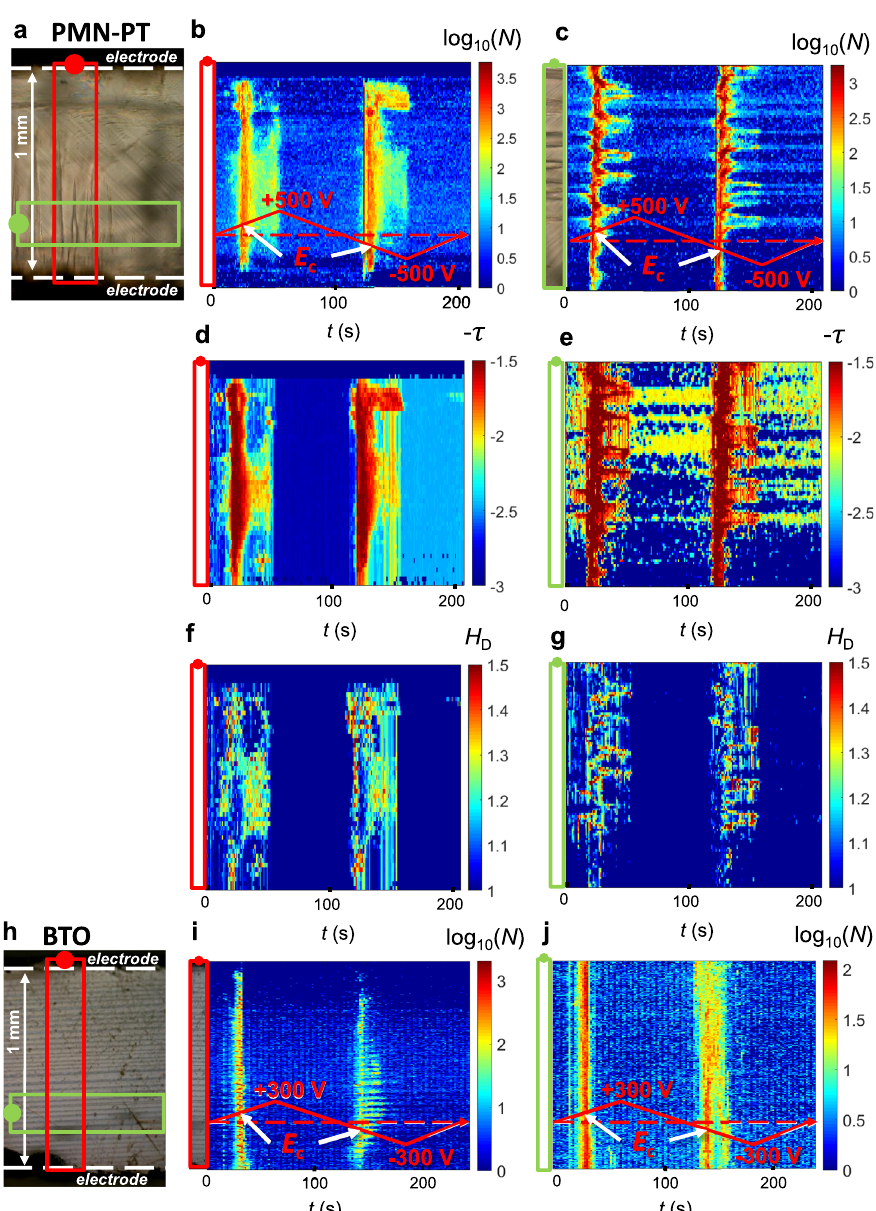
Fig. 2 Spatiotemporal avalanche maps. Spatiotemporal avalanche maps for a – g PMN-PT and h – j BTO samples. The red and green rectangles in the optical images a and h are analysed further in b , d , f , i (red) and c , e , g , j (green). Accumulated avalanche activities integrated over space N for b , c PMN-PT and i , j BTO. d , e The avalanche exponent τ and f , g the Hausdorff dimension H D are shown for PMN-PT. Similar graphs for BTO are shown in the Supplementary Note